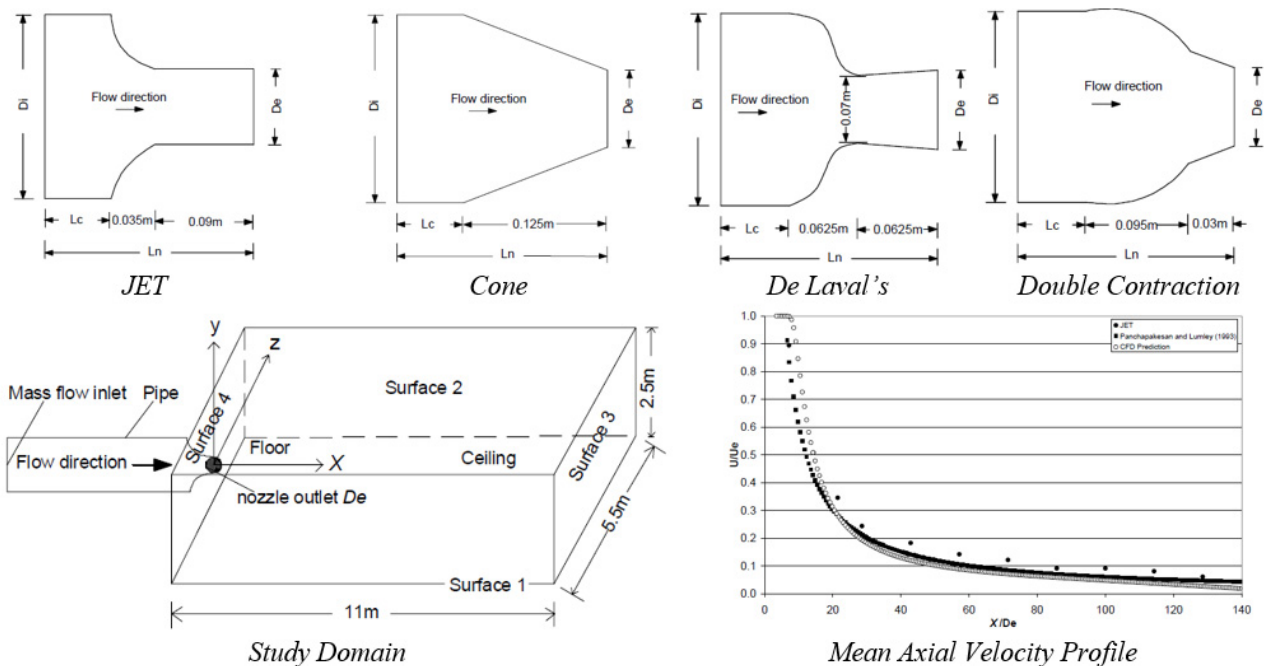
Figure 21. Different kinds of nozzle being studied and respective performance [83]. Liao et al. [84], 2017, studied the flow field of a nozzle water jets based on a mathe- matical model adhering to the theory of hydrodynamics. The study was focused on the impact of convergence angle and diameter of nozzle on water jet flow field. In a water jets, the longest instance of acceleration was found with a 13° angle where the water jet velocity is maximum and forms longest core length. When increased to 30° and 60° the velocity core length and acceleration length decreased. For diameter variation it has also been summarized, that with large nozzle diameter, higher axial pressure can be achieved. Figure 22 shows the nozzle geometry and contour plot. Figure 22. Velocity of water at 30° angle [84]. Kwidzinski [85] developed a mathematical model to predict the flow parameters in a characteristic cross-section of steam water injector (Figure 23). It is a steam driven system with accelerated and expanded steam being mixed with water, which is being drawn due to low static pressure at MC. Two phases at different temperature and velocities exchange mass, momentum and energy, during condensation. With pressure wave developed post t, two-phase flow gets compressed, with decreasing flow velocity and complete conden- sation.